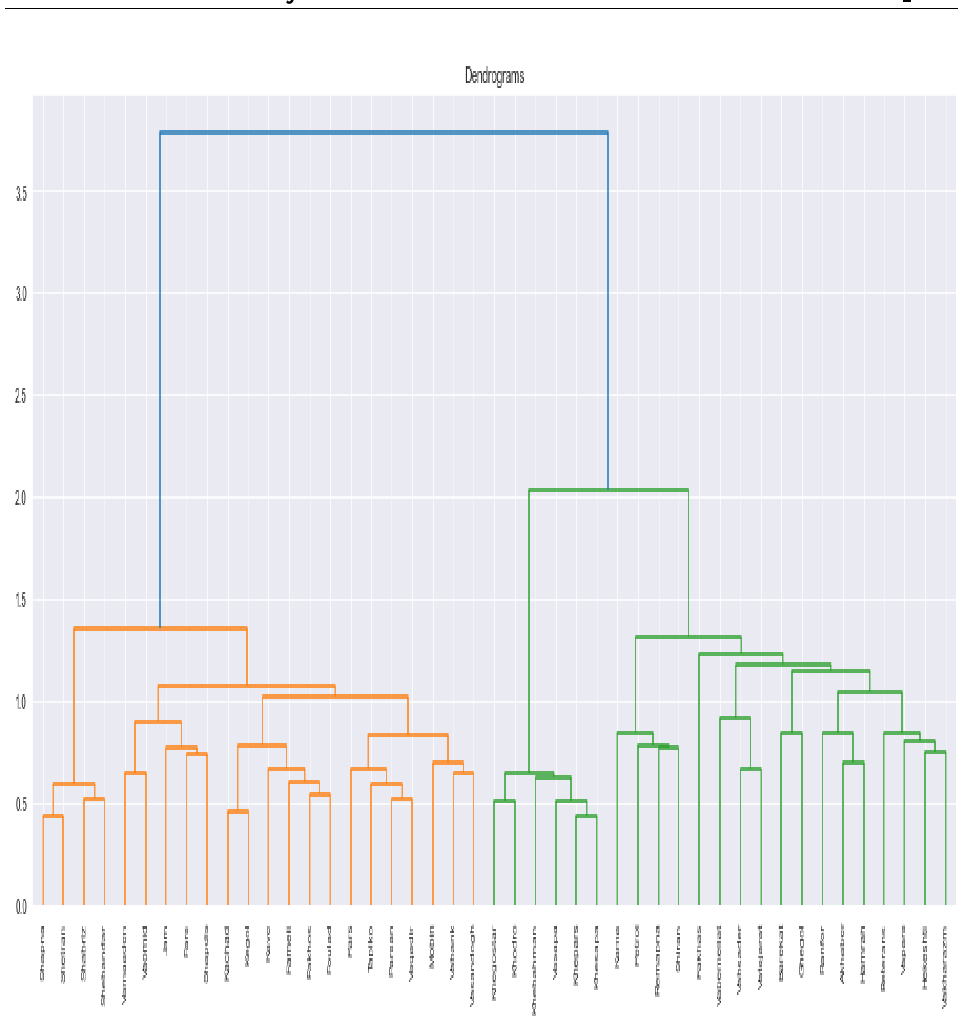
Fig 8. Dendrogram